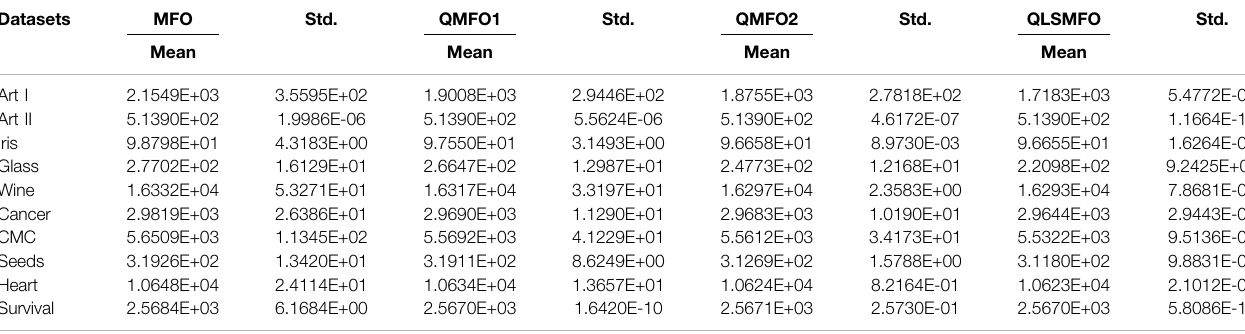
TABLE 5 | Numerical results of improved algorithms with different strategies on 10 clustered data. Datasets MFO Std. QMFO1 Std. QMFO2 Std. QLSMFO